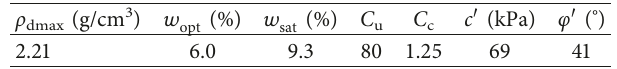
Figure 4: Particle size distribution curve of the tested soil. Table 2: Properties of the tested